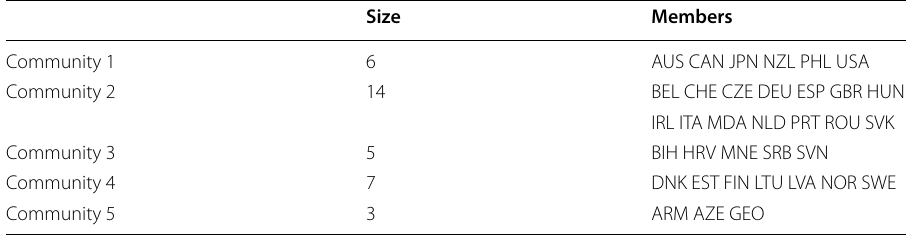
Table 4 Members of the five most populous communities in 2019